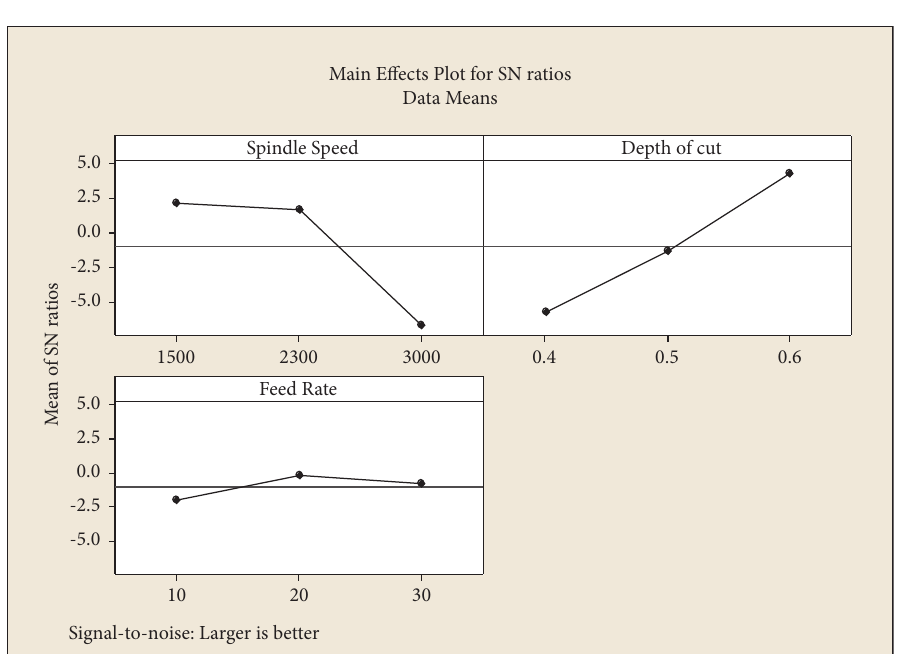
Figure 7: S/N plot for